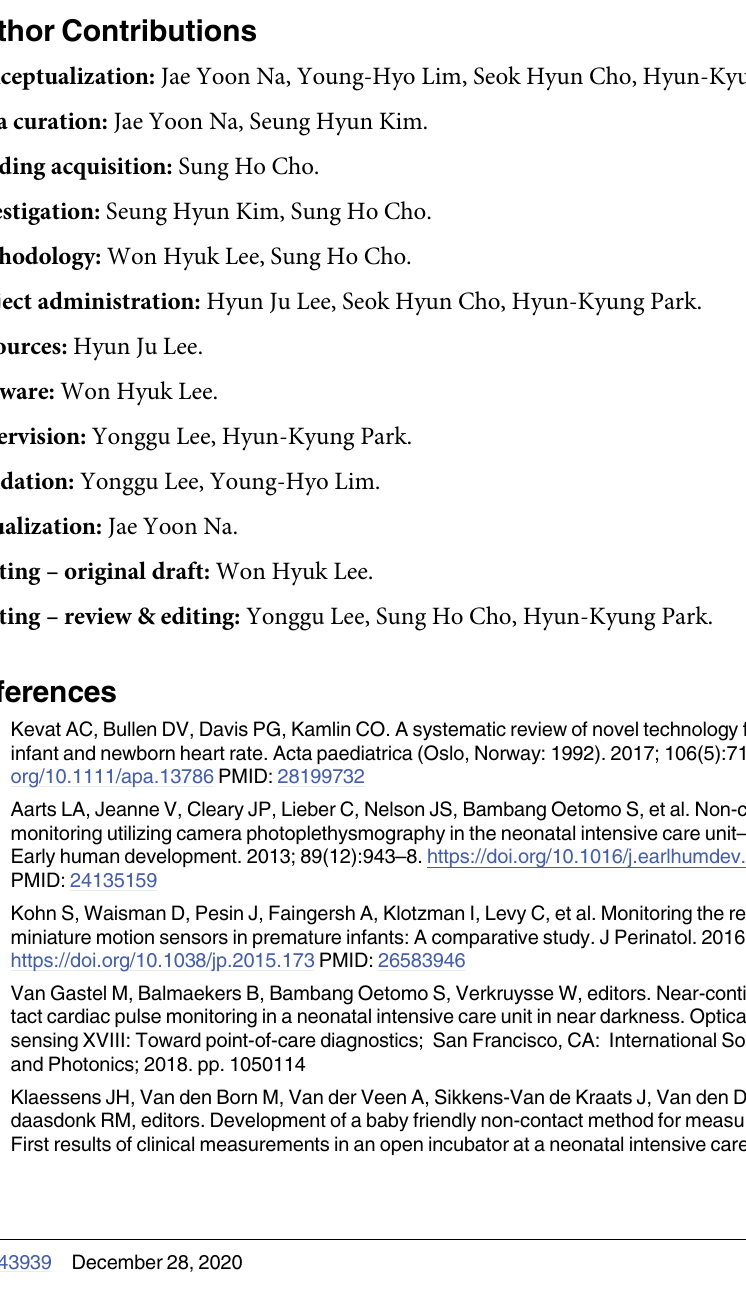
S1 Table. Agreement between IR-UWB Radar and ECG/IPG for HR and RR measurements when the neonates were stable: Signal matching, correlations, and differences according to the BW